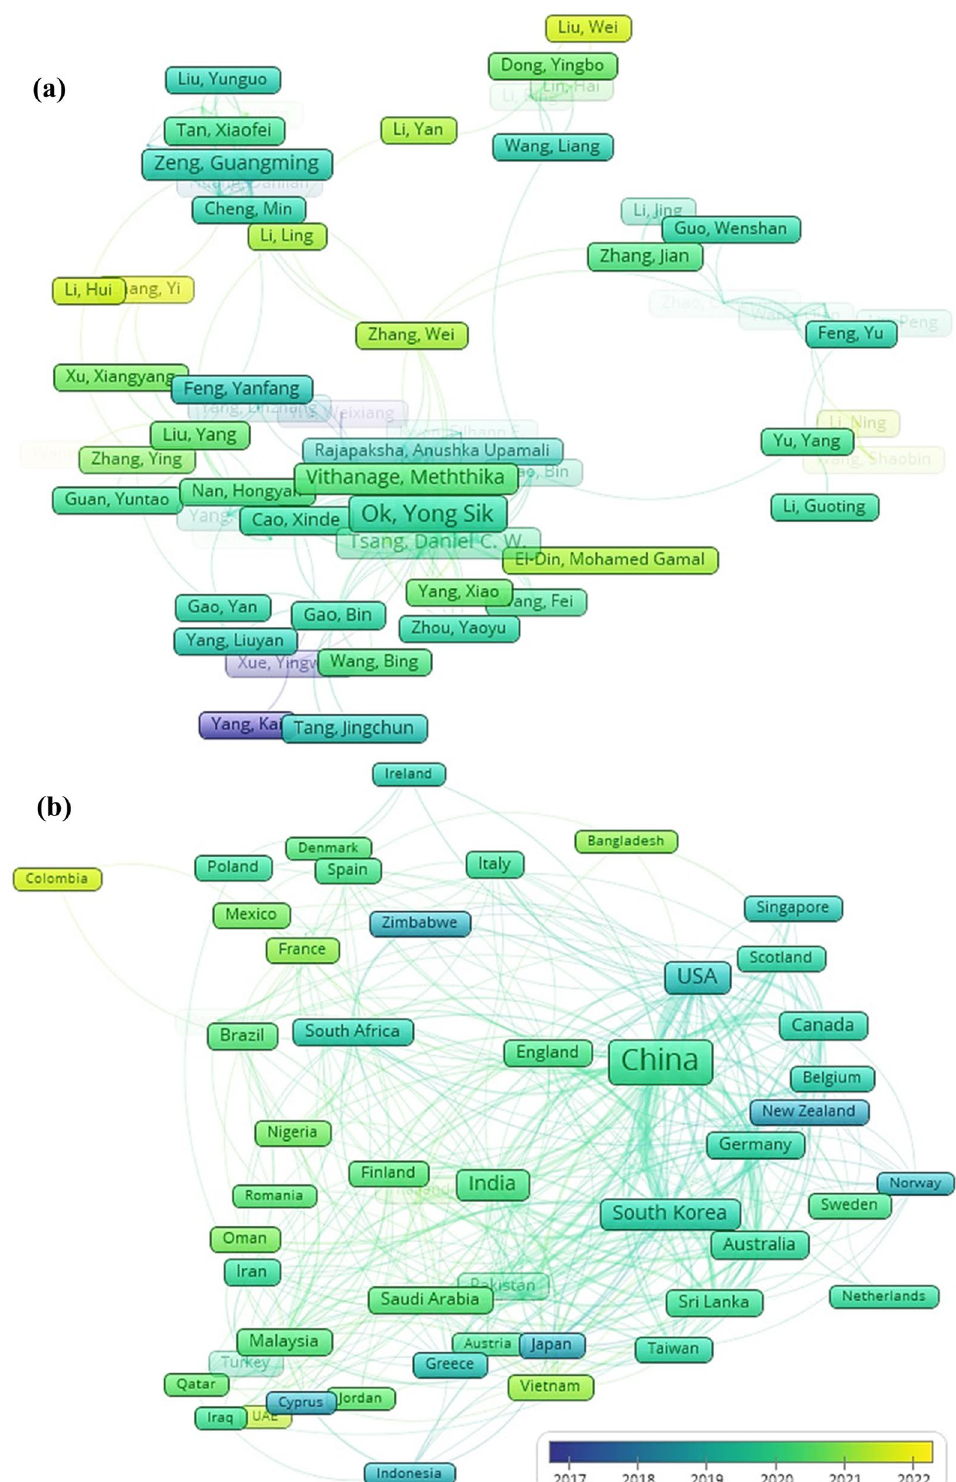
Fig. 7 Bibliometric network for treatment of polluted water between a authors and b countries for minimum 5 document